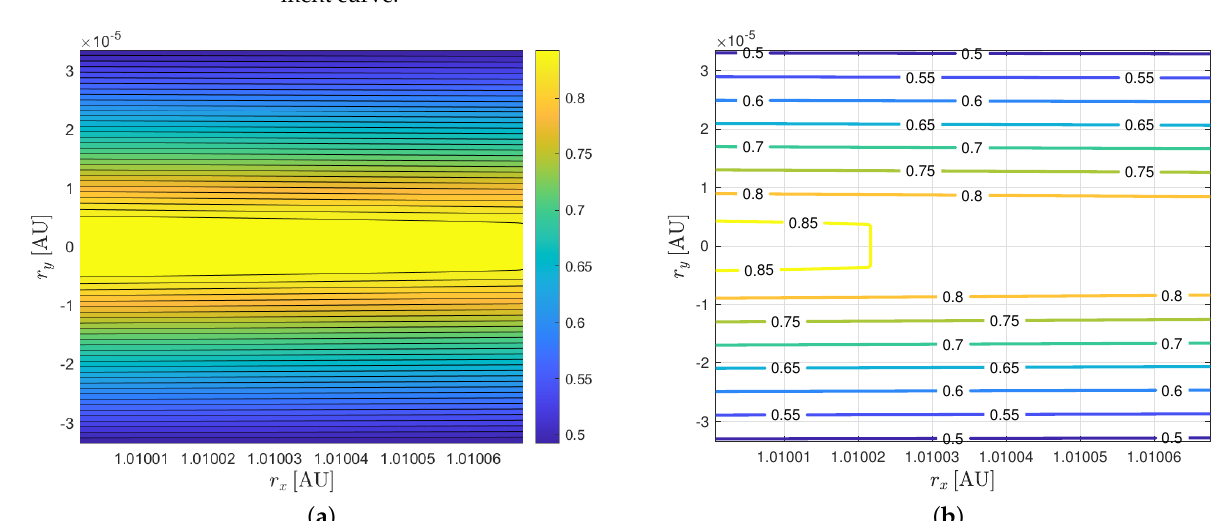
Figure 8. Contour lines of measurements near the nominal track. ( a ) Outline of the nominal track. ( b ) Contour map of the nominal